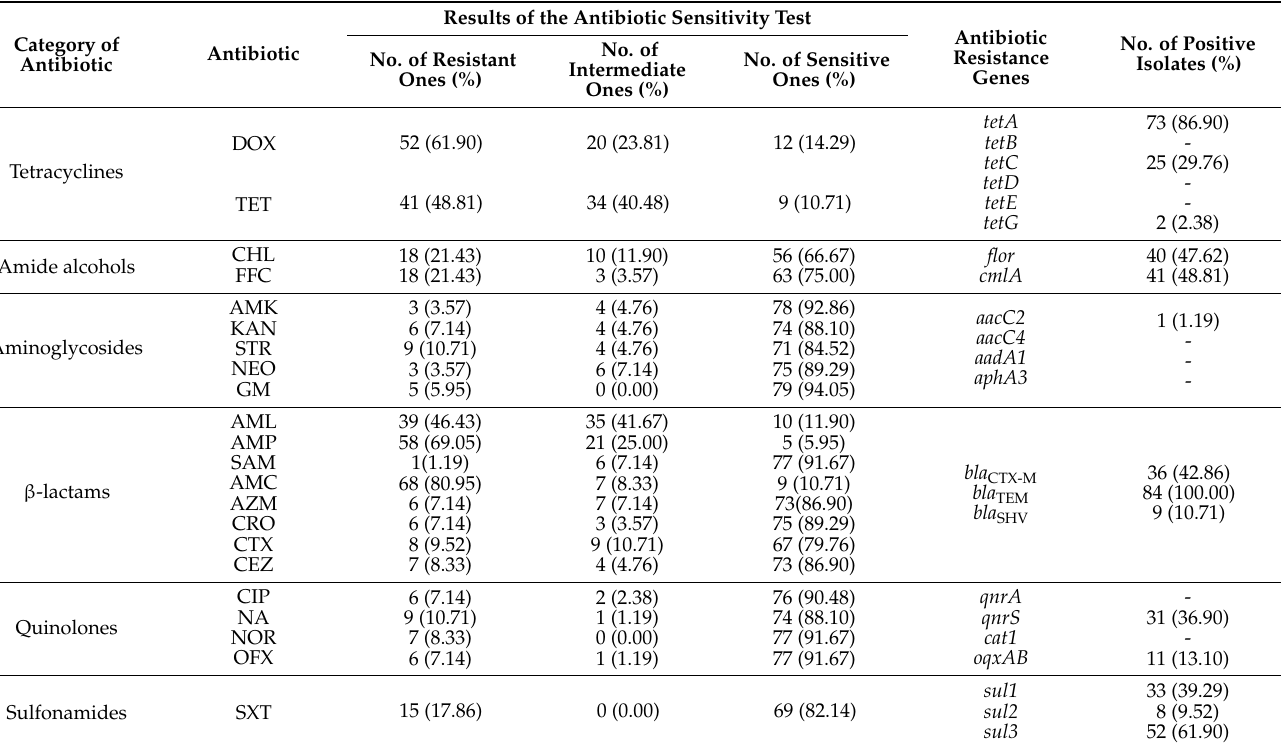
Table 2. Distribution of antibiotic resistance phenotypes and antibiotic resistance genes detected in E. coli strains isolated from captive giant pandas (n = 84).